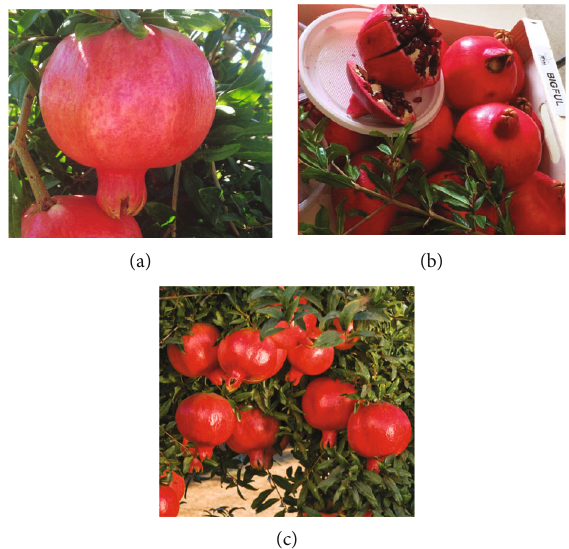
Figure 1: Pomegranate cultivars studied: (a) Acco, (b) Big Full, and (c) Wonderful.